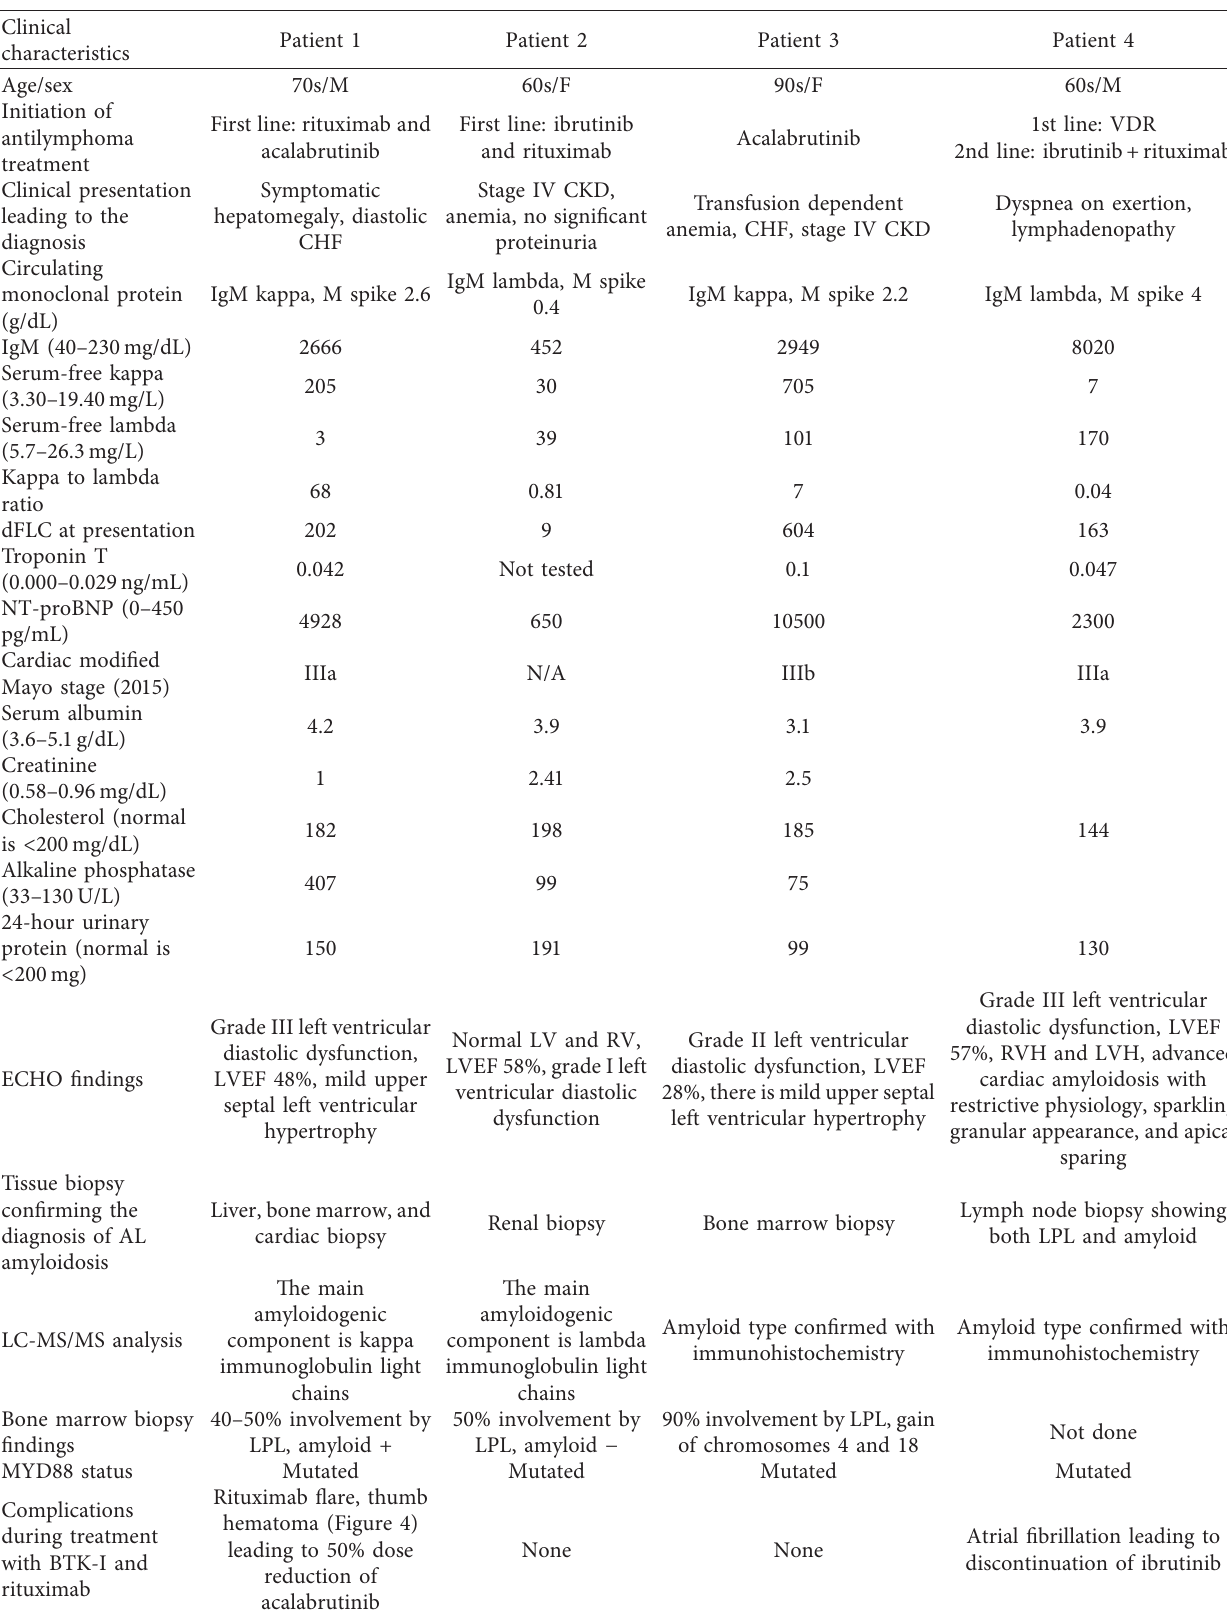
Table 1: Patient